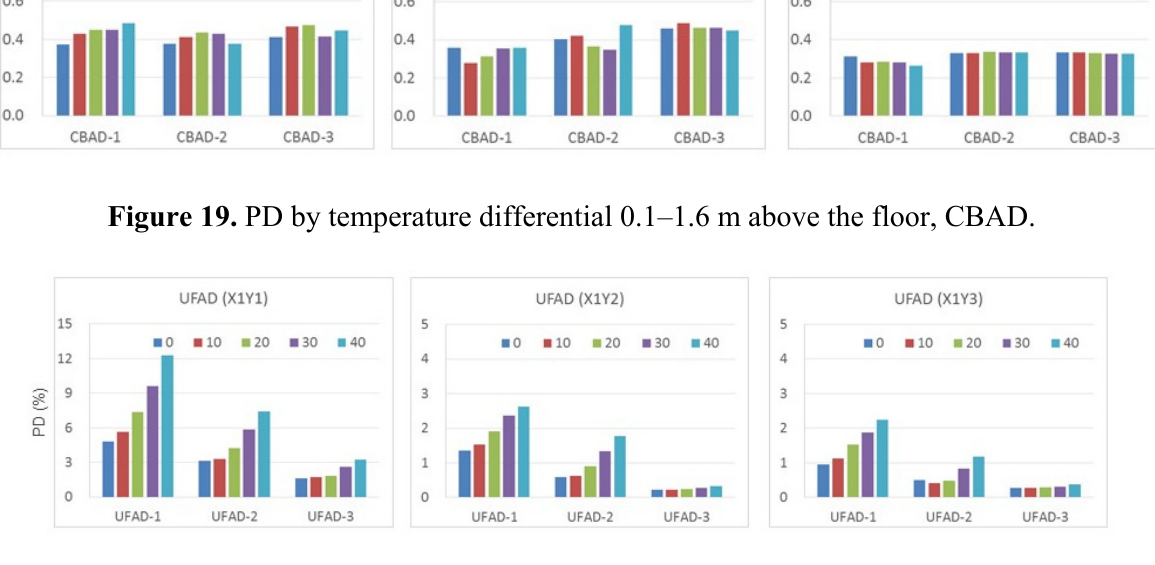
Figure 20. PD by temperature differential 0.1–1.6 m above the floor,